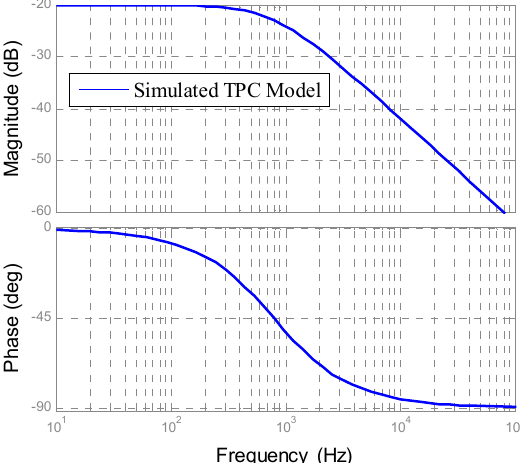
Figure 6. The frequency response of the thermal positioning controller (TPC) model .